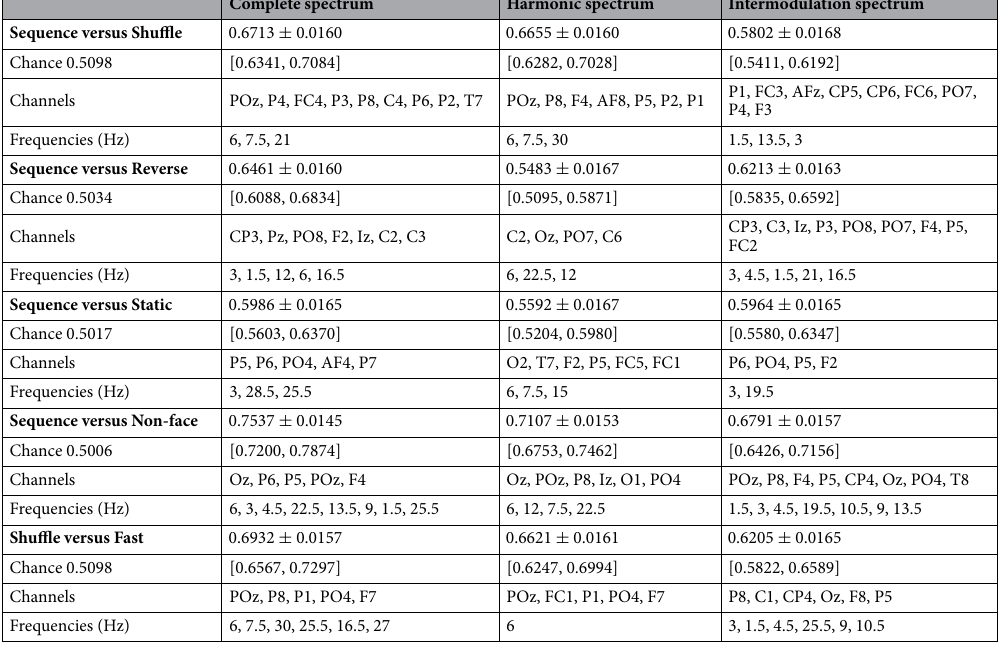
Table 2. Pairwise classification results of our multivariate pattern analysis are presented below. First row: classification accuracy ± standard deviation across subjects, second row: 99% confidence interval for the reported accuracy, third row: identified channels, and fourth row: selected frequency components in the corresponding spectrum with the multiclass accuracy in the bottom row. Comparisons of other condition pairs is given in the